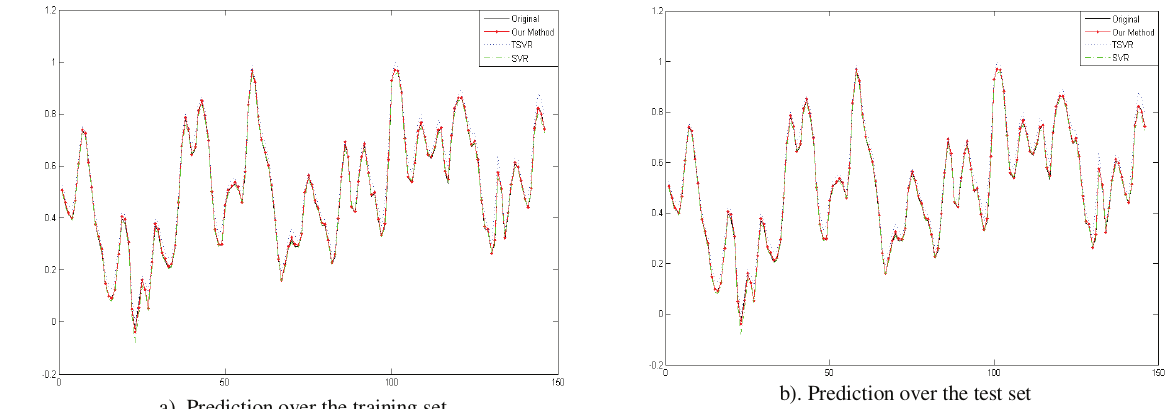
Figure 2: Results of comparison for gas furnace data of Box-Jenkins. Gaussian kernel was